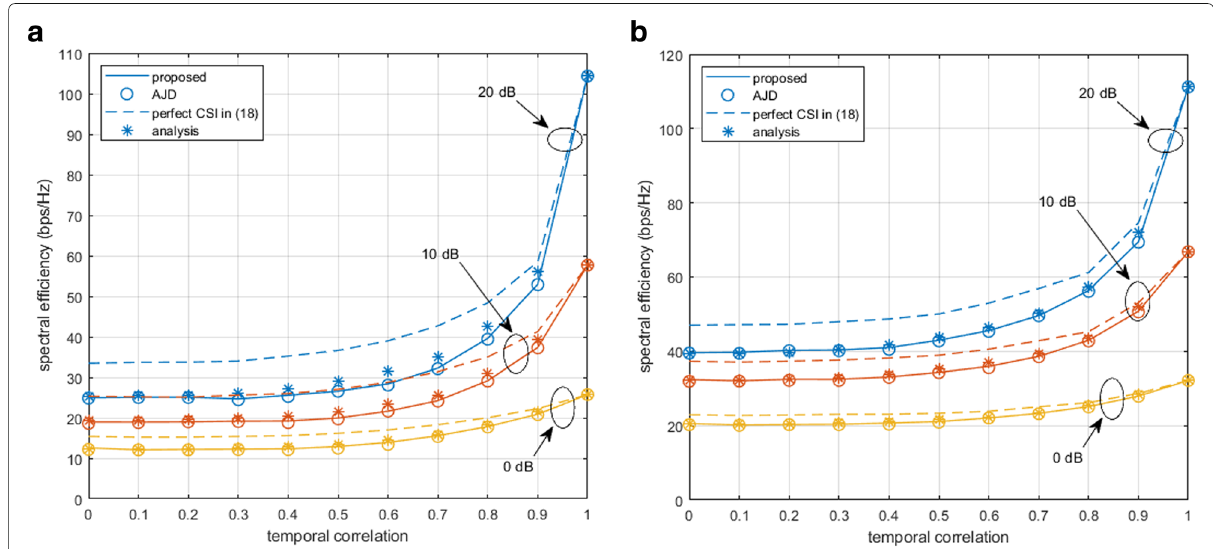
Fig. 2 Spectral efficiency according to channel variation. a When N R = 4. b When N R = 8